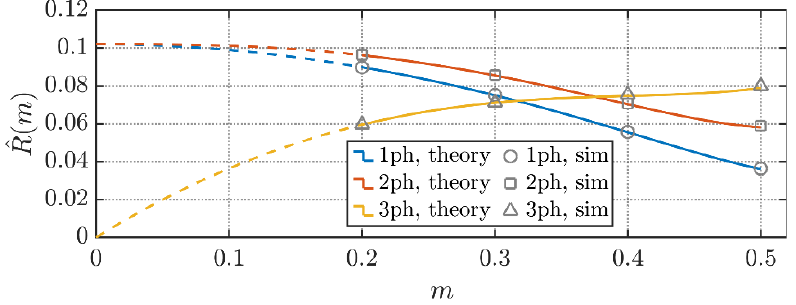
Figure 14. Normalized dc-link switching voltage ripple rms (ˆ R ) as a function of the modulation index ( m ) for studied cases: balanced load (3ph), two-phase load (2ph), and single-phase load (1ph).